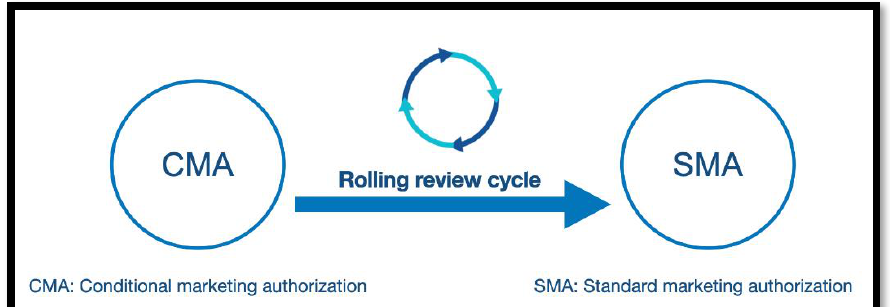
Figure 1. The conversion process from conditional marketing authorization to standard marketing authorization.